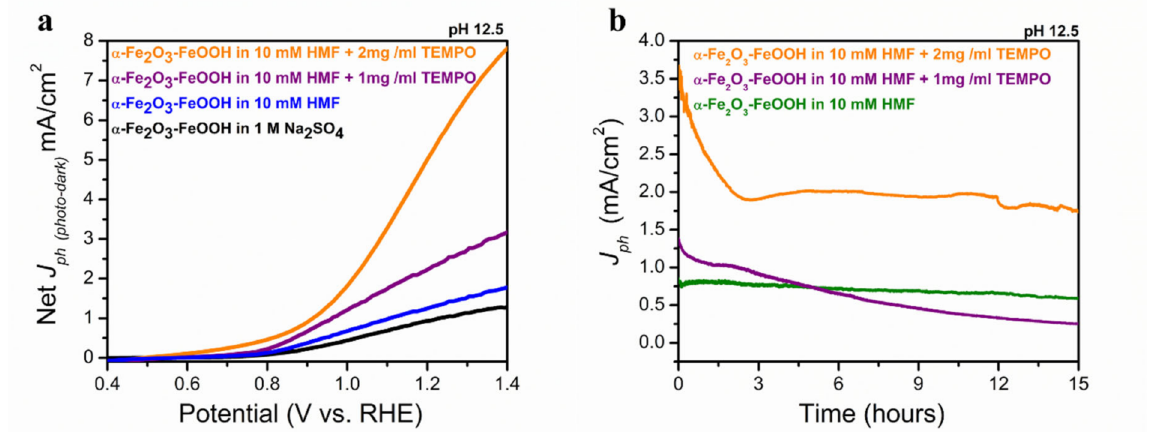
Figure 2. ( a ) Net photocurrent responses for 5-HMF photooxidation at pH 12.5 and ( b ) corresponding chronoamperometry (CA) response at 1.1 V RHE